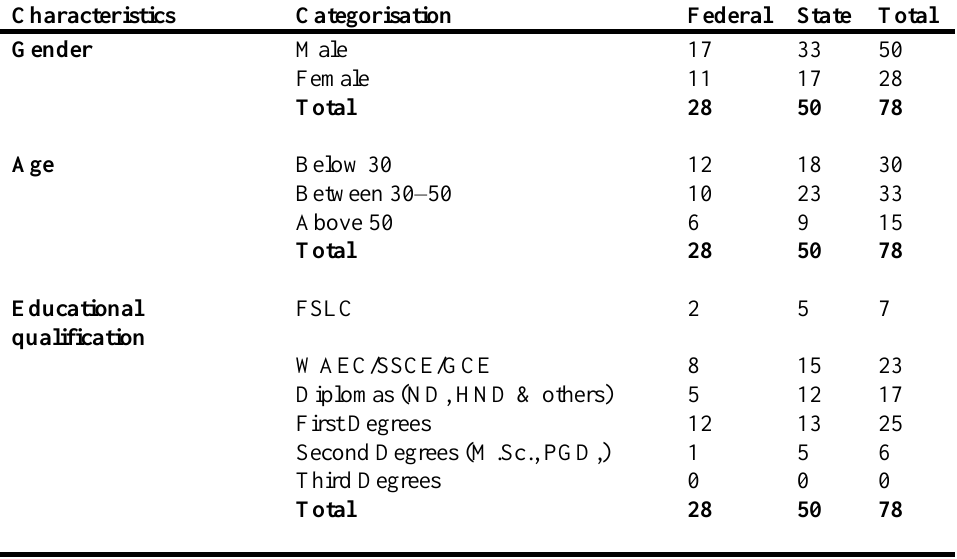
Table 4. Respondents’ Characteristics (developed by the authors) Characteristics